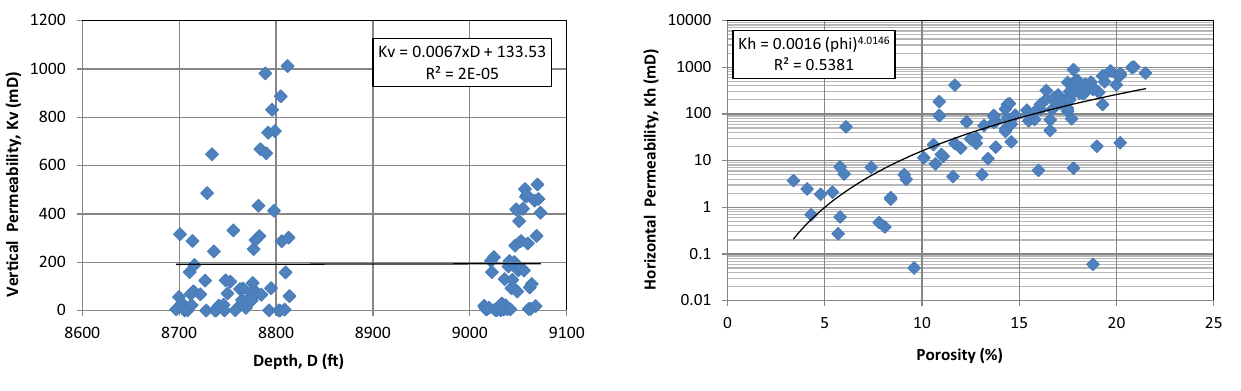
Fig. 1 Variation of vertical permeability with depth